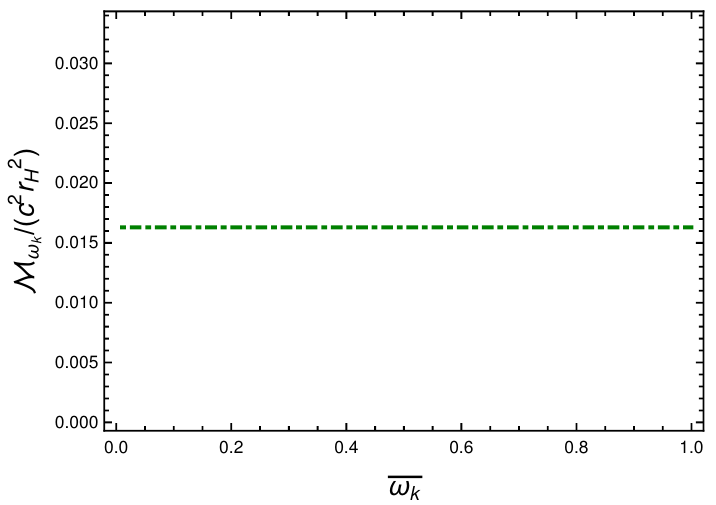
( ρ ) / ( c 2 α 2 ) in (1 + 1) dimensional de Sitter spacetime AB d k = α for fixed transition frequency ∆ E = α ∆ E = 1 , and fixed d/α k d ω k d